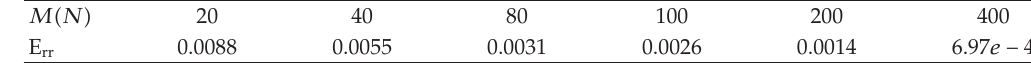
Table 1: Errors in the solutions at t (cid:8) 0 . 4 with number of grids.